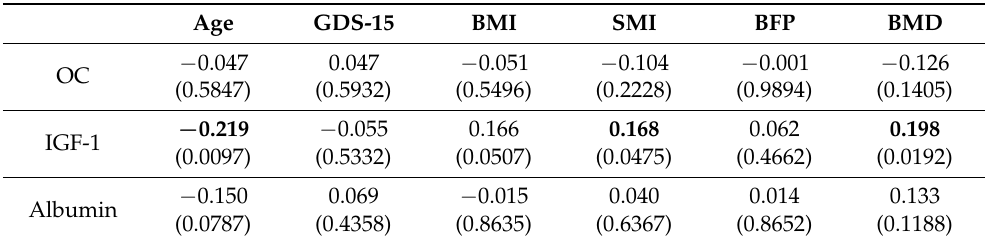
Table 5. Correlation coefficients for serum substances and age, GDS-15 score, and body composition